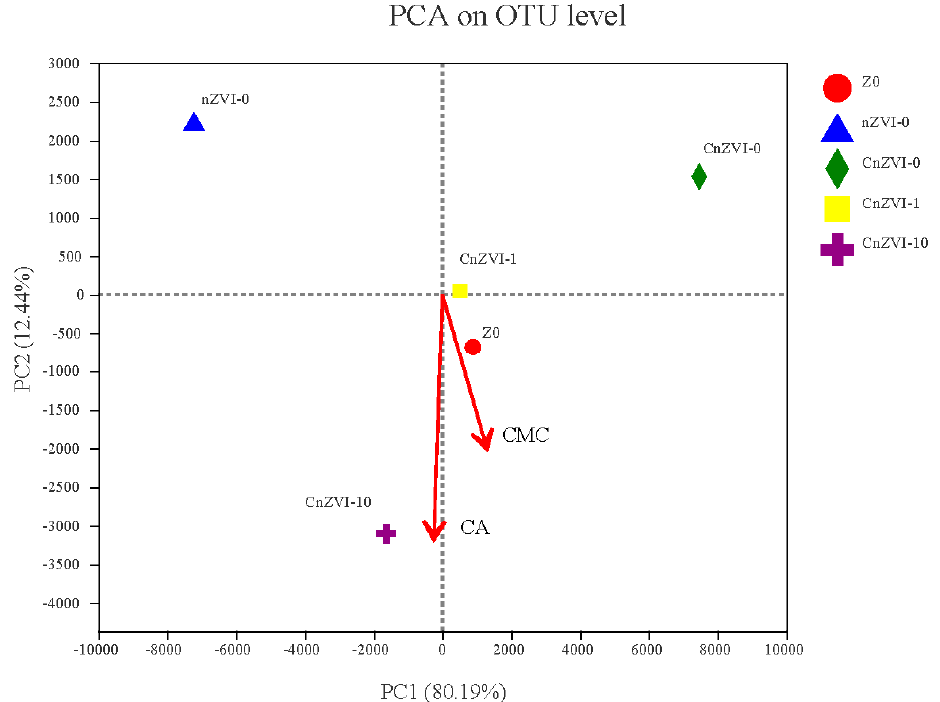
Figure 9. Output of the principal component analysis (PCA) among the 5 samples. Score plot of the first and second principal components (PC1, PC2, respectively).